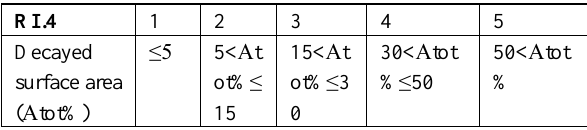
Table 6. Estimated percentage area by each decay